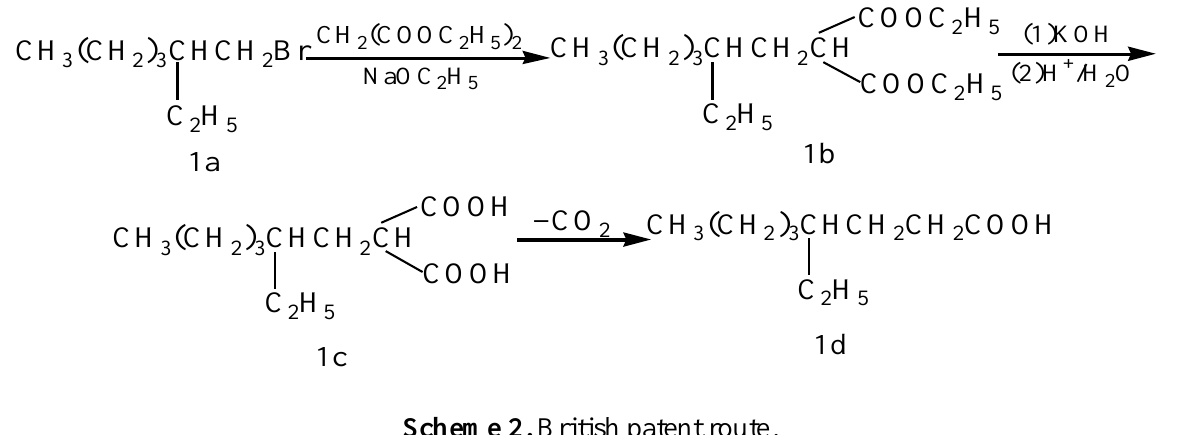
Scheme 2. British patent route.